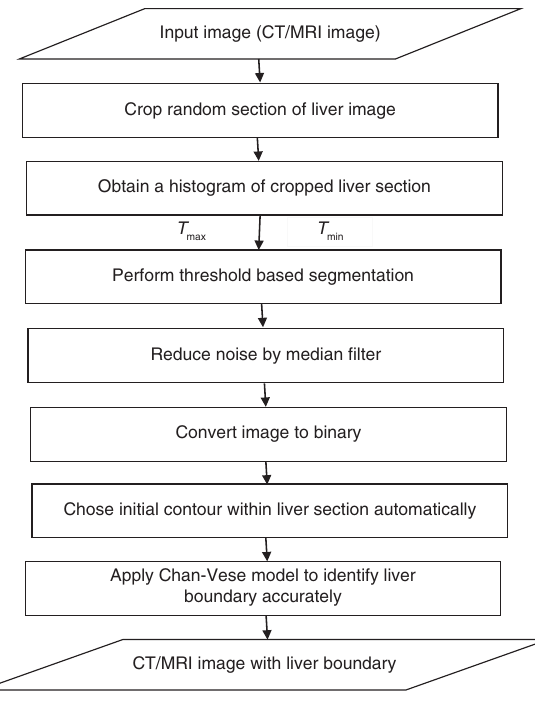
Figure 1: Process of Proposed